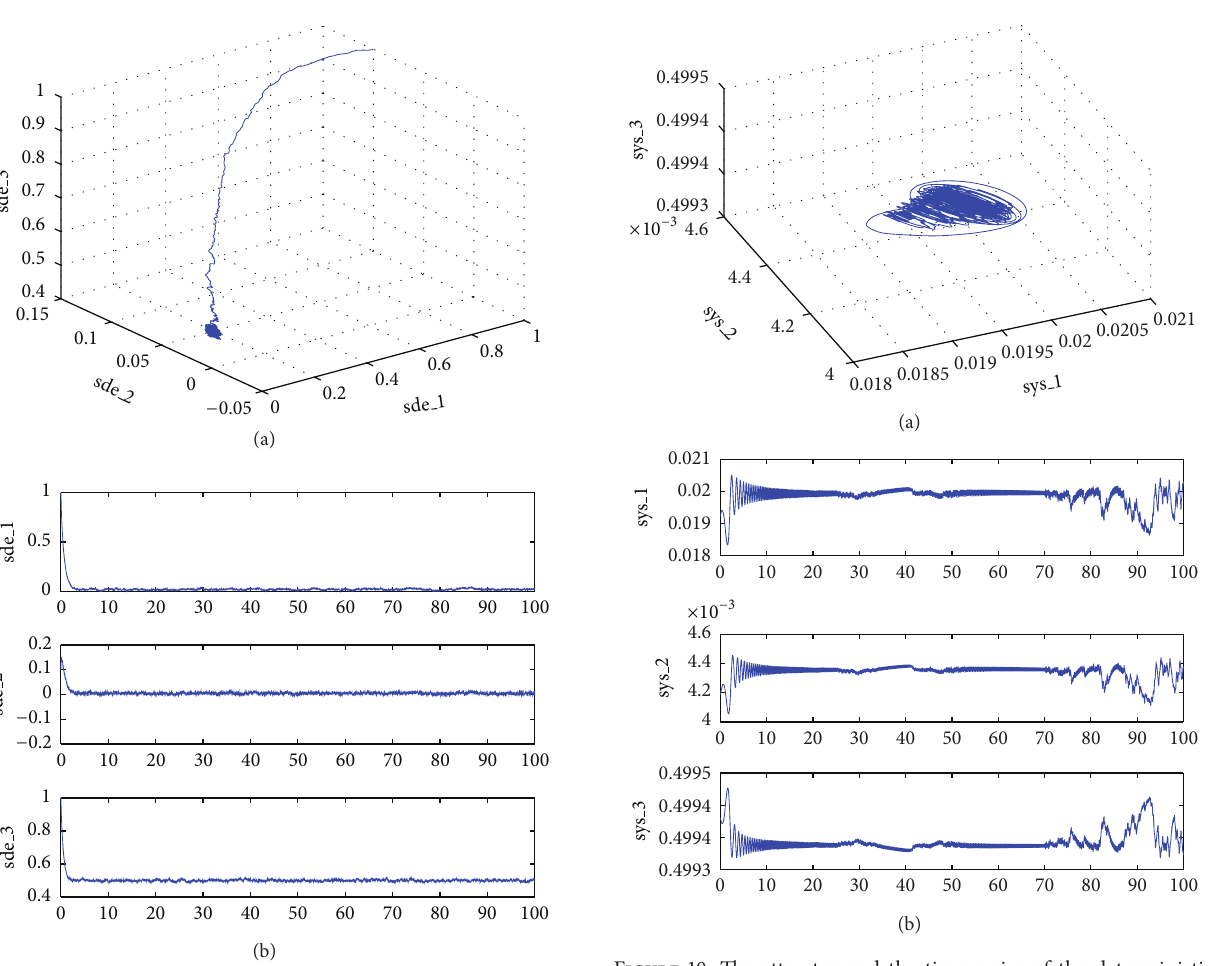
Figure9:TheattractorandthetimeseriesoftheStochasticLorentz-